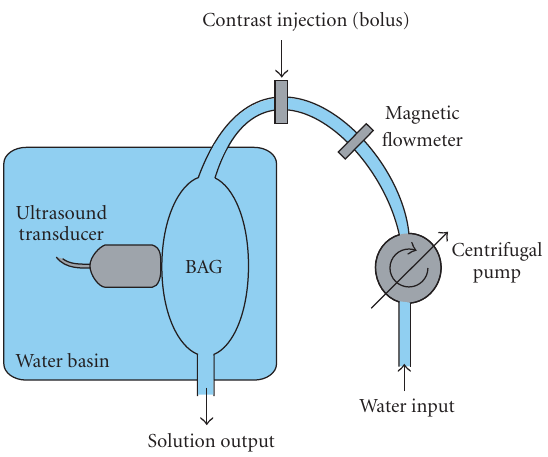
Figure 10: Experimental flow-measurement